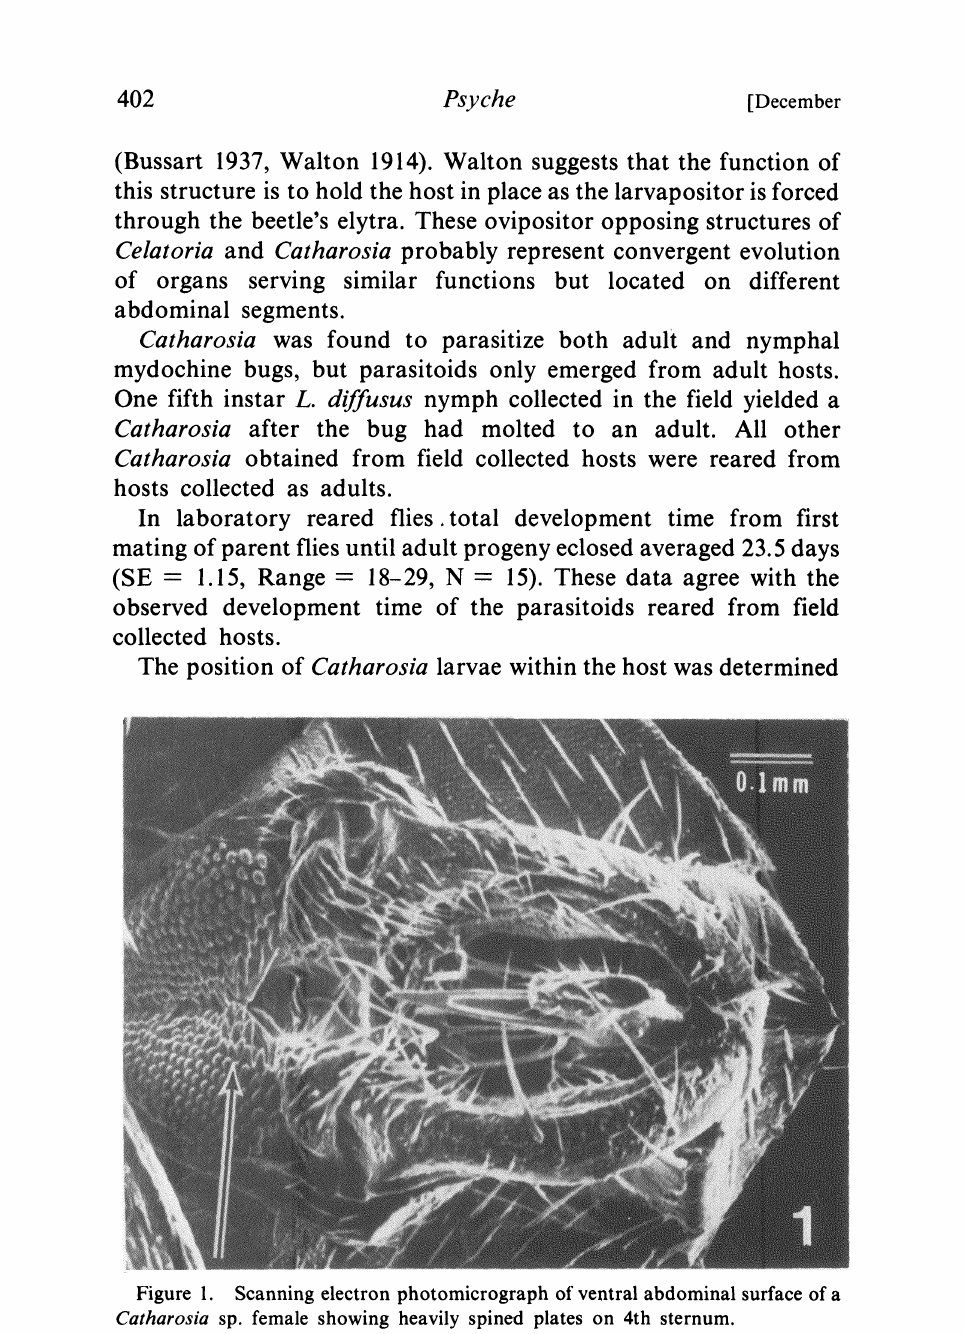
Figure 1. Scanning electron photomicrograph of ventral abdominal surface of a Catharosia sp. female showing heavily spined plates on 4th